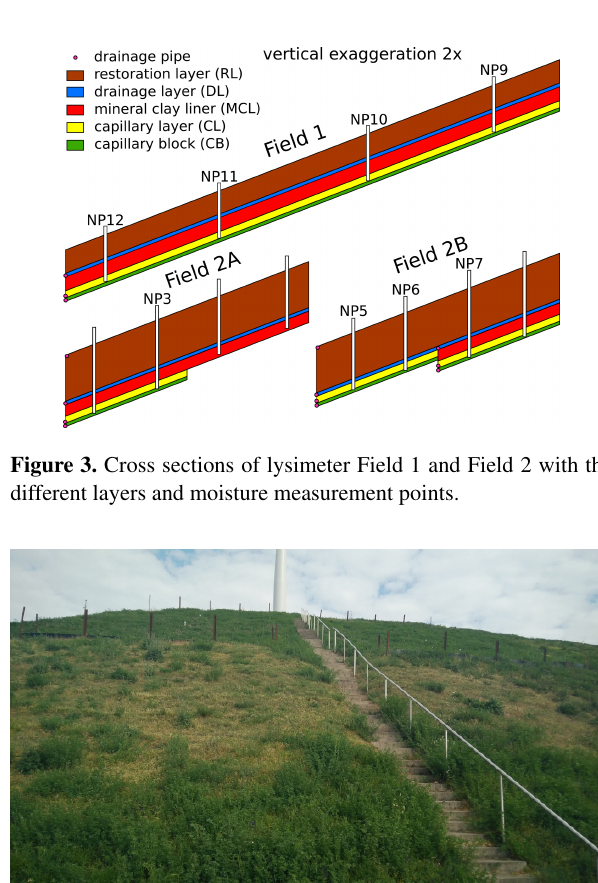
Figure 2. Location of the study site on a municipal landfill site in Karlsruhe, Germany, and locations of the weather stations used in this study. Lysimeter 2 consists of two separate fields (Field 2A, Field 2B).